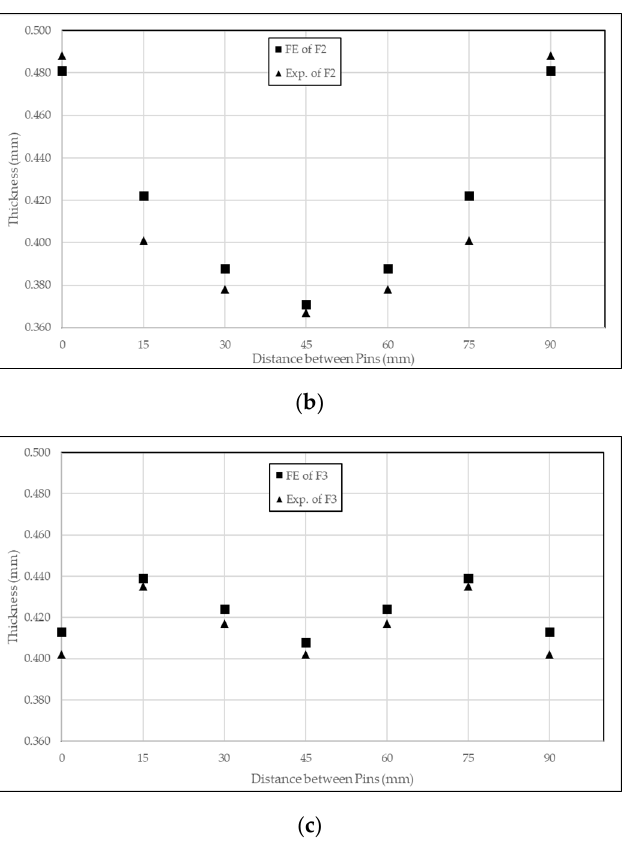
Figure 17. Comparison of thicknesses between simulations and experiments ( a ) form1; ( b ) form2; ( c )